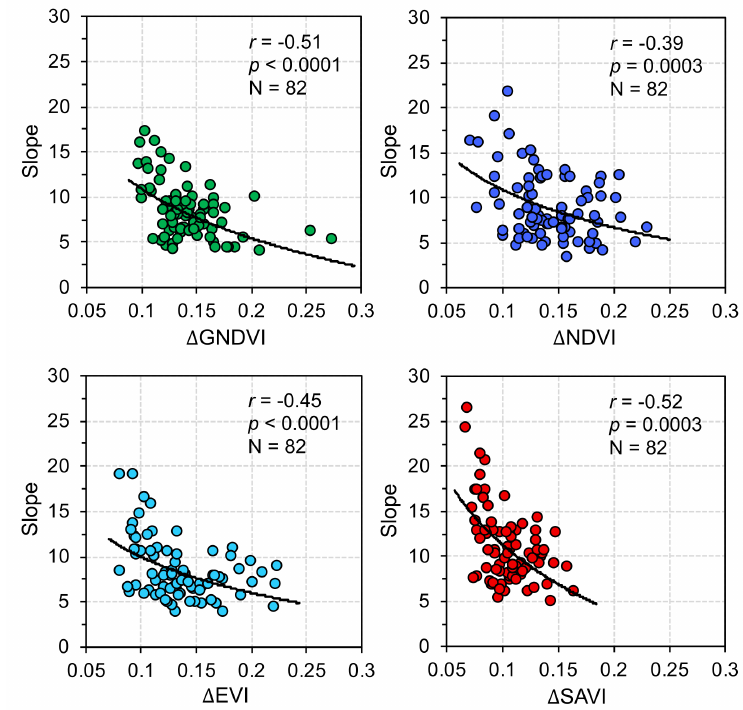
Figure 8. The relationship between the ∆ VI and the slope of the VI- Ψ stem linear fit in the 82 vineyards. Notice that a larger slope signifies weaker response of VI to increasing stress (i.e., to decreasing Ψ stem